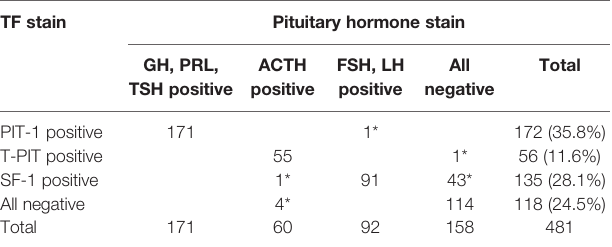
TABLE 3 | Comparison between immunohistochemical stain for TFs and pituitary hormones.